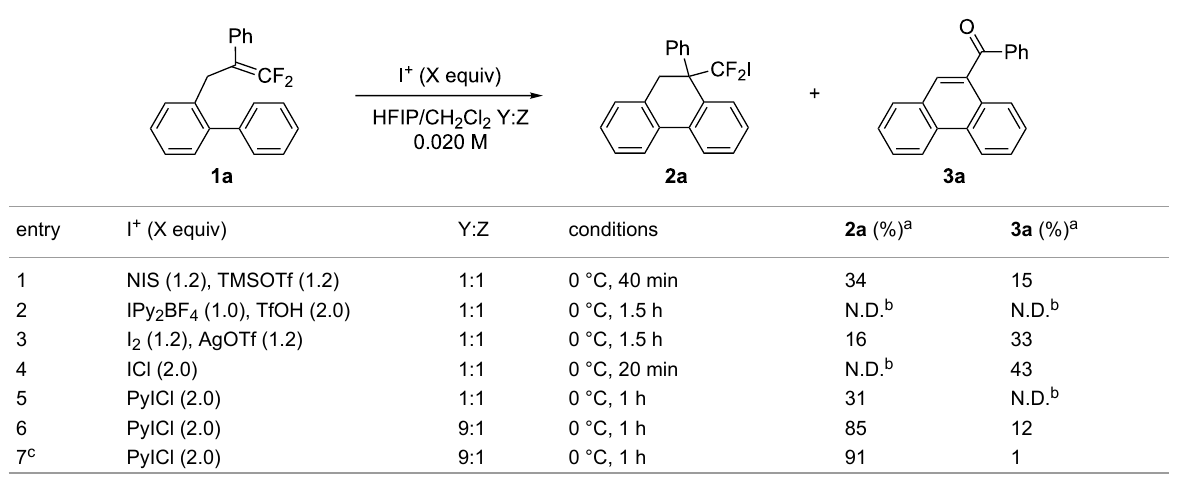
Table 1: Screening of conditions for the iodoarylation of 1a